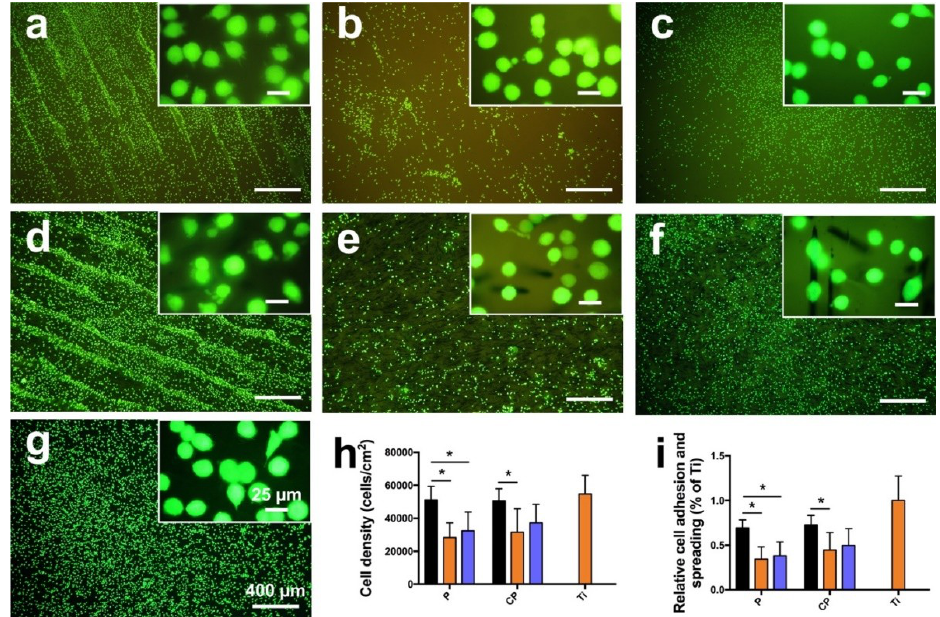
Figure 7. LIVE/DEAD staining of L929 cells on PEEK and CFR‐PEEK samples after culturing for 24 h, with Ti as an additional control. ( a ) untreated PEEK; ( b ) polished PEEK; ( c ) sandblasted PEEK; ( d ) untreated CFR‐PEEK; ( e ) polished CFR‐PEEK; ( f ) sandblasted CFR‐PEEK; ( g ) Ti. Figure 7( h , i ) shows the quantitative cell density and quantification of the mean surface area covered by cells. The data are presented as means ± standard deviation, * p < 0.05. P: PEEK; CP: CFR‐PEEK; black bar: untreated group; orange bar: polished group; blue bar: sandblasted group. Cytotoxic effects, indicated by dead (red stained) cells, are not detectable.